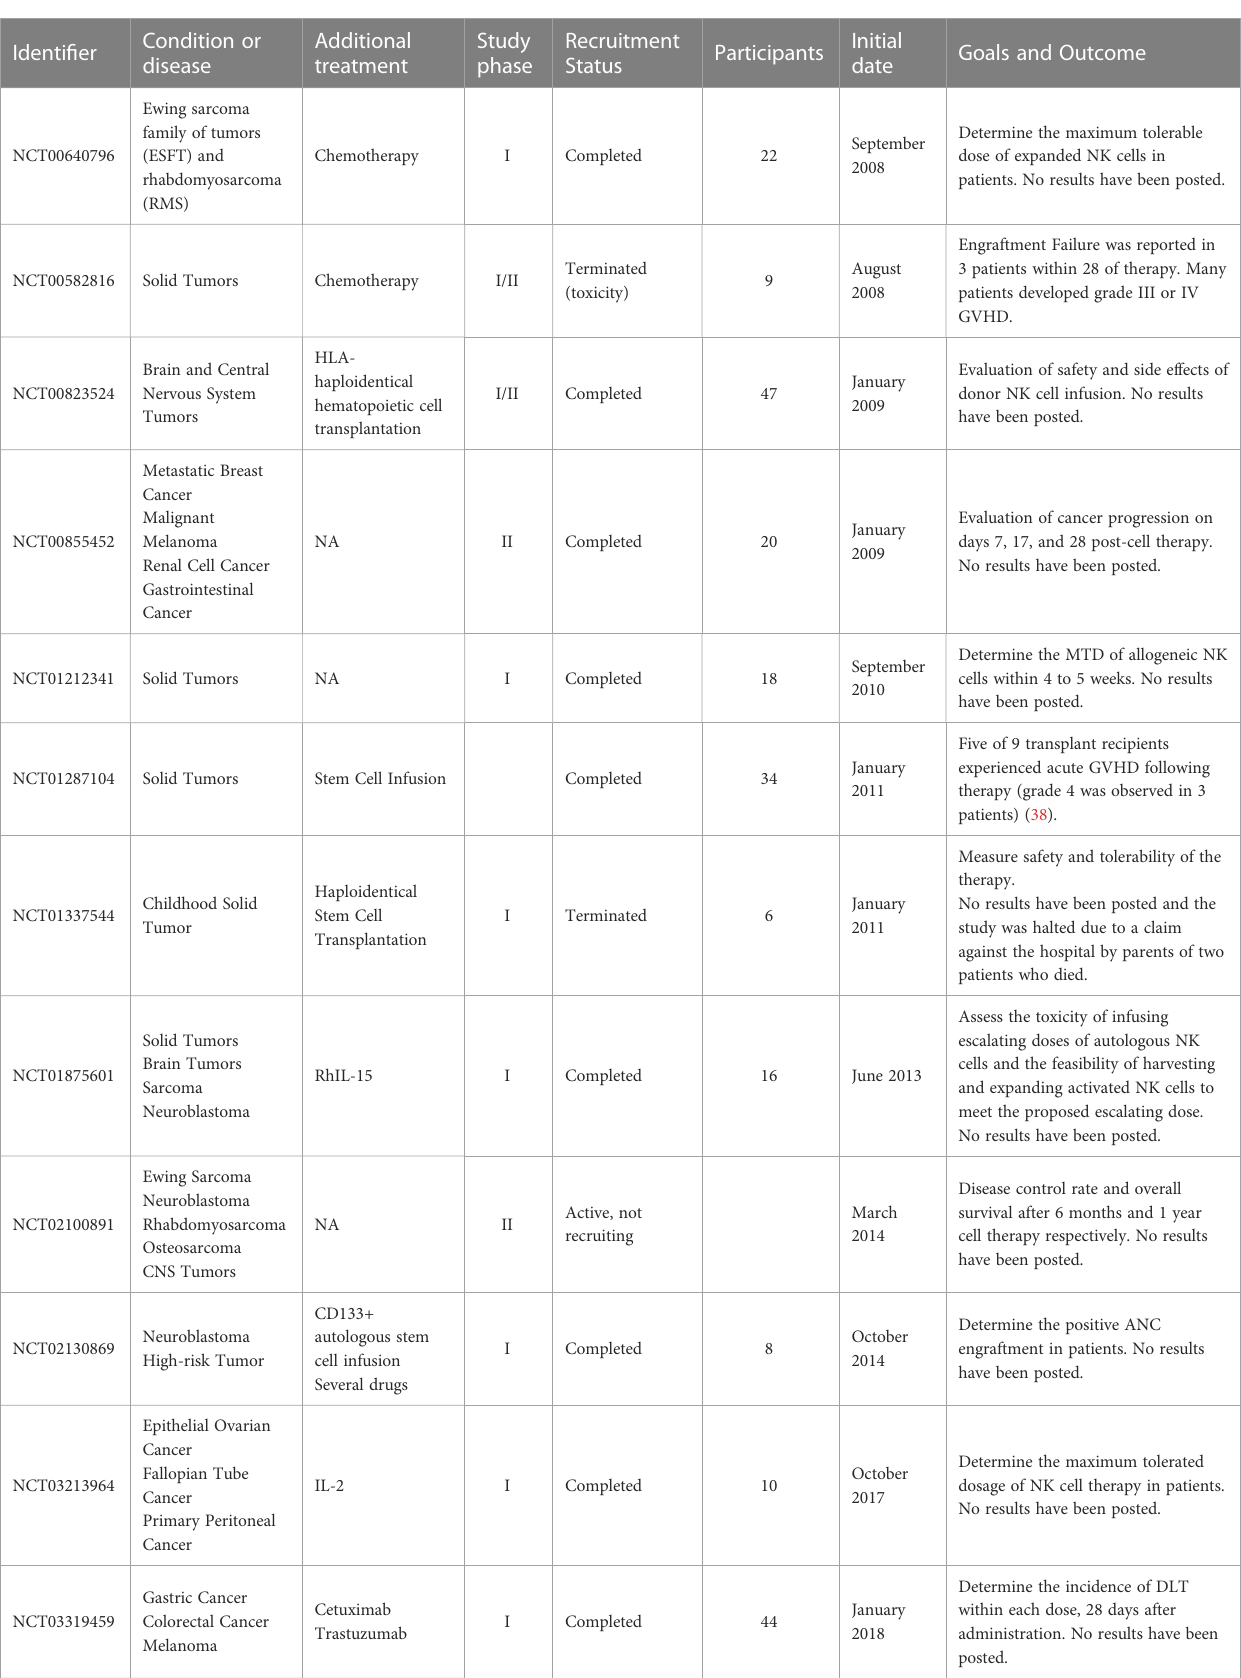
TABLE 1 Allogeneic NK cells clinical trials against solid